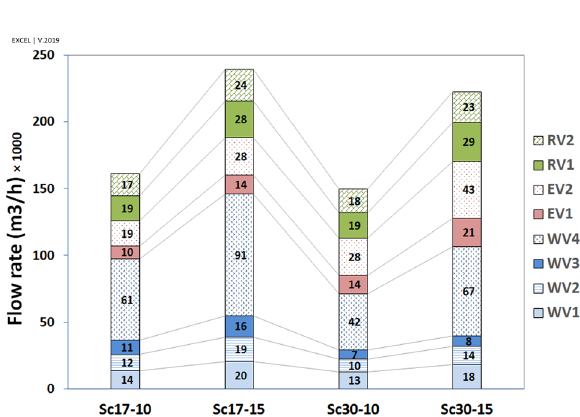
Figure 17. Pressure gradient in ( a ) western and ( b ) eastern vents.